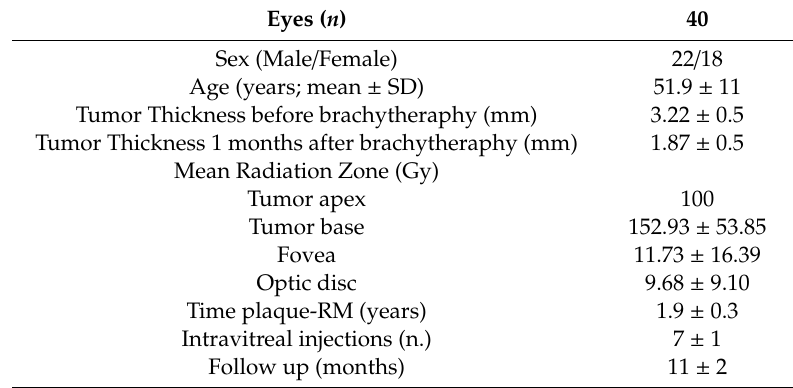
Table 1. Demographic characteristics, radiation parameters, number of injections and follow up in patients with radiation maculopathy. Eyes ( n ) 40 Sex (Male / Female) 22 / 18 Age (years; mean ±